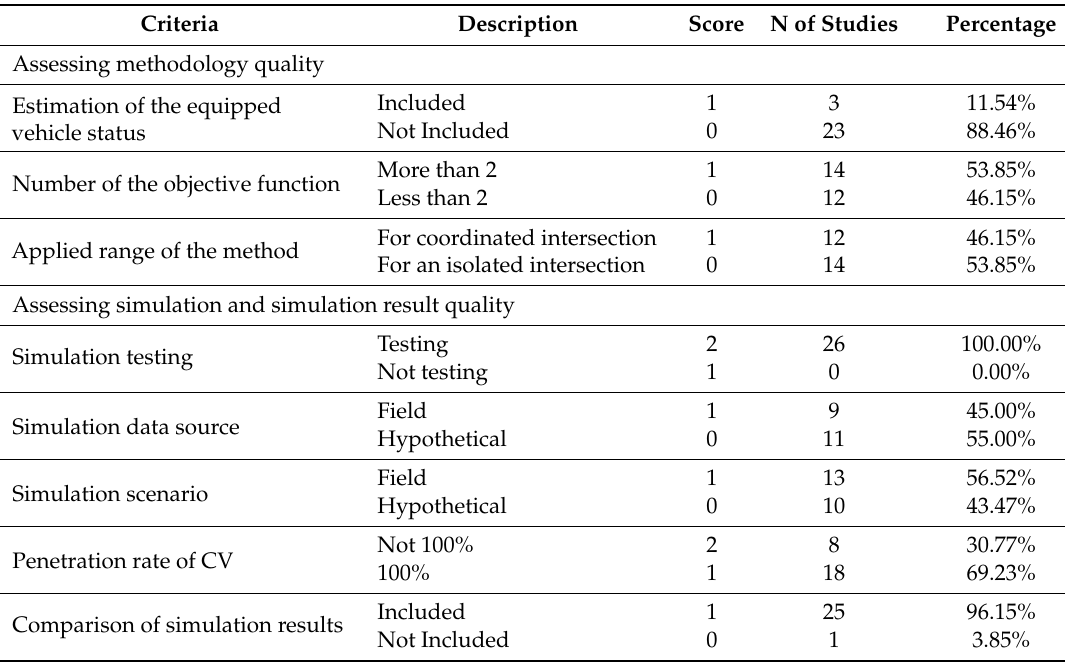
Table 5. Distribution of quality characteristics across reviewed